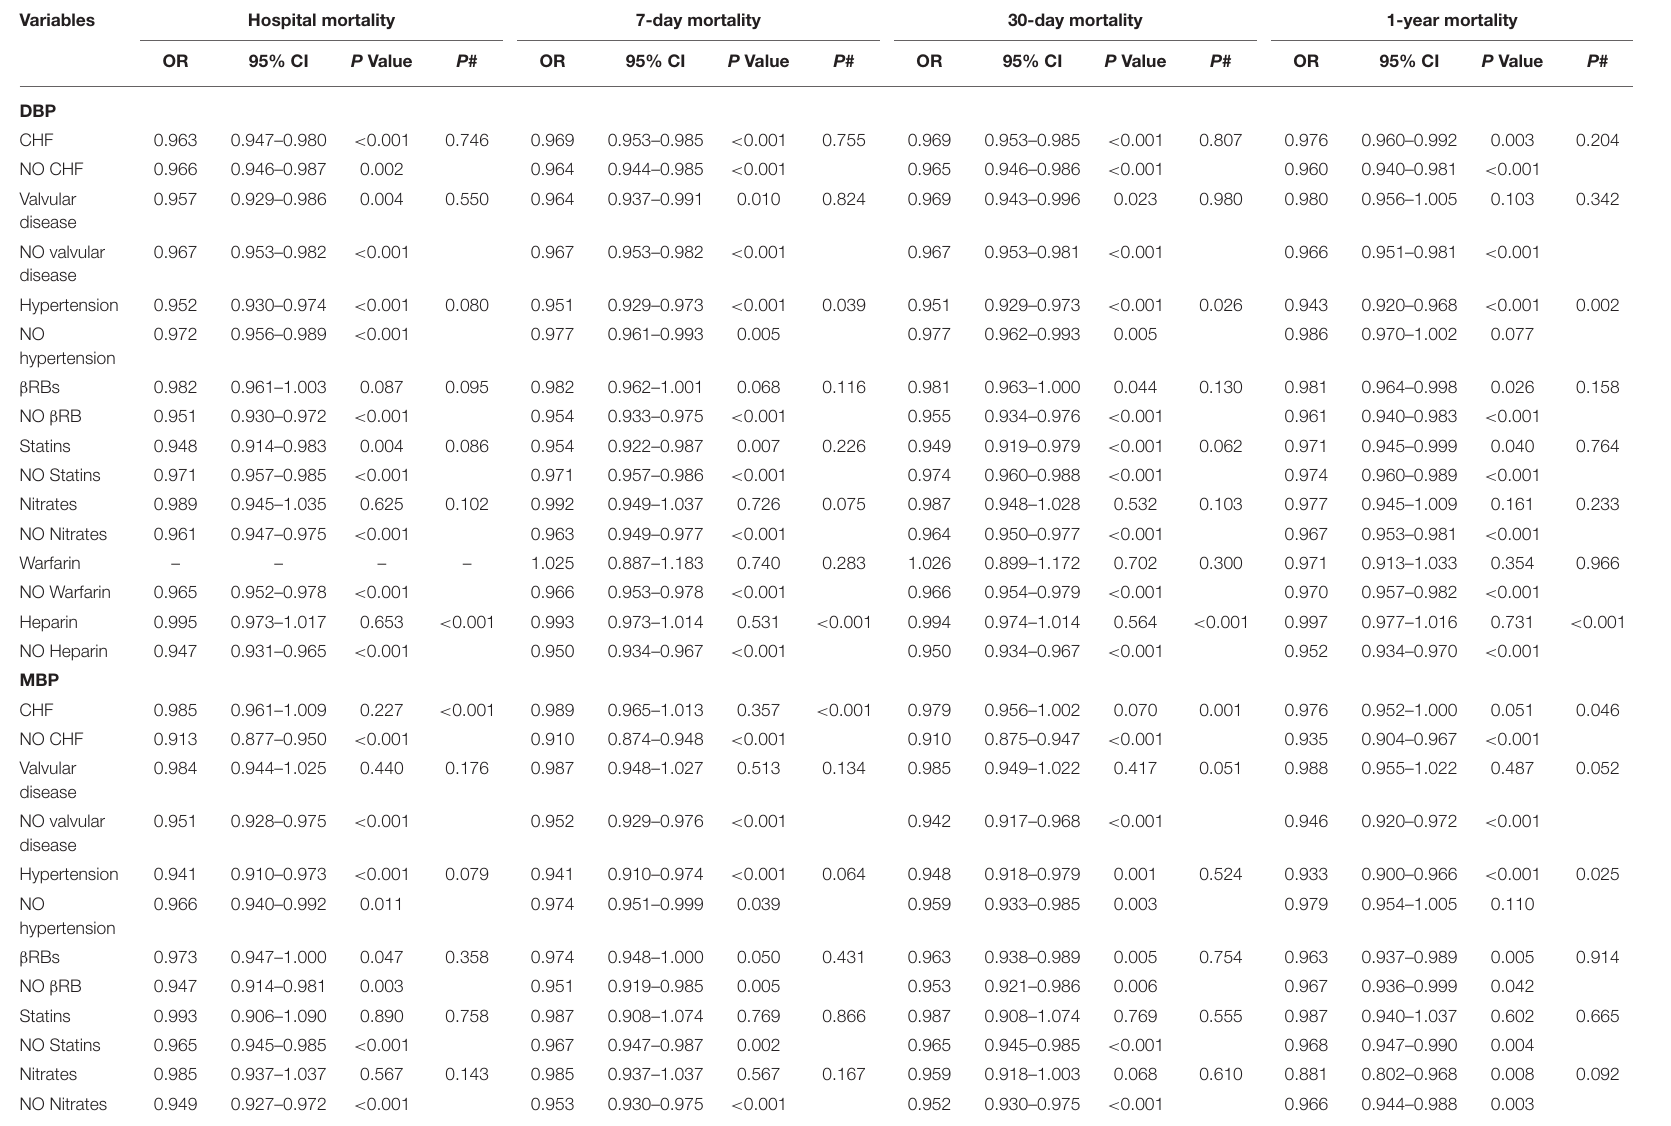
TABLE 6 | Multiple logistic regression analysis for relationship between between BP ( ≤ 55/70/110 mmHg) and mortality by stratified